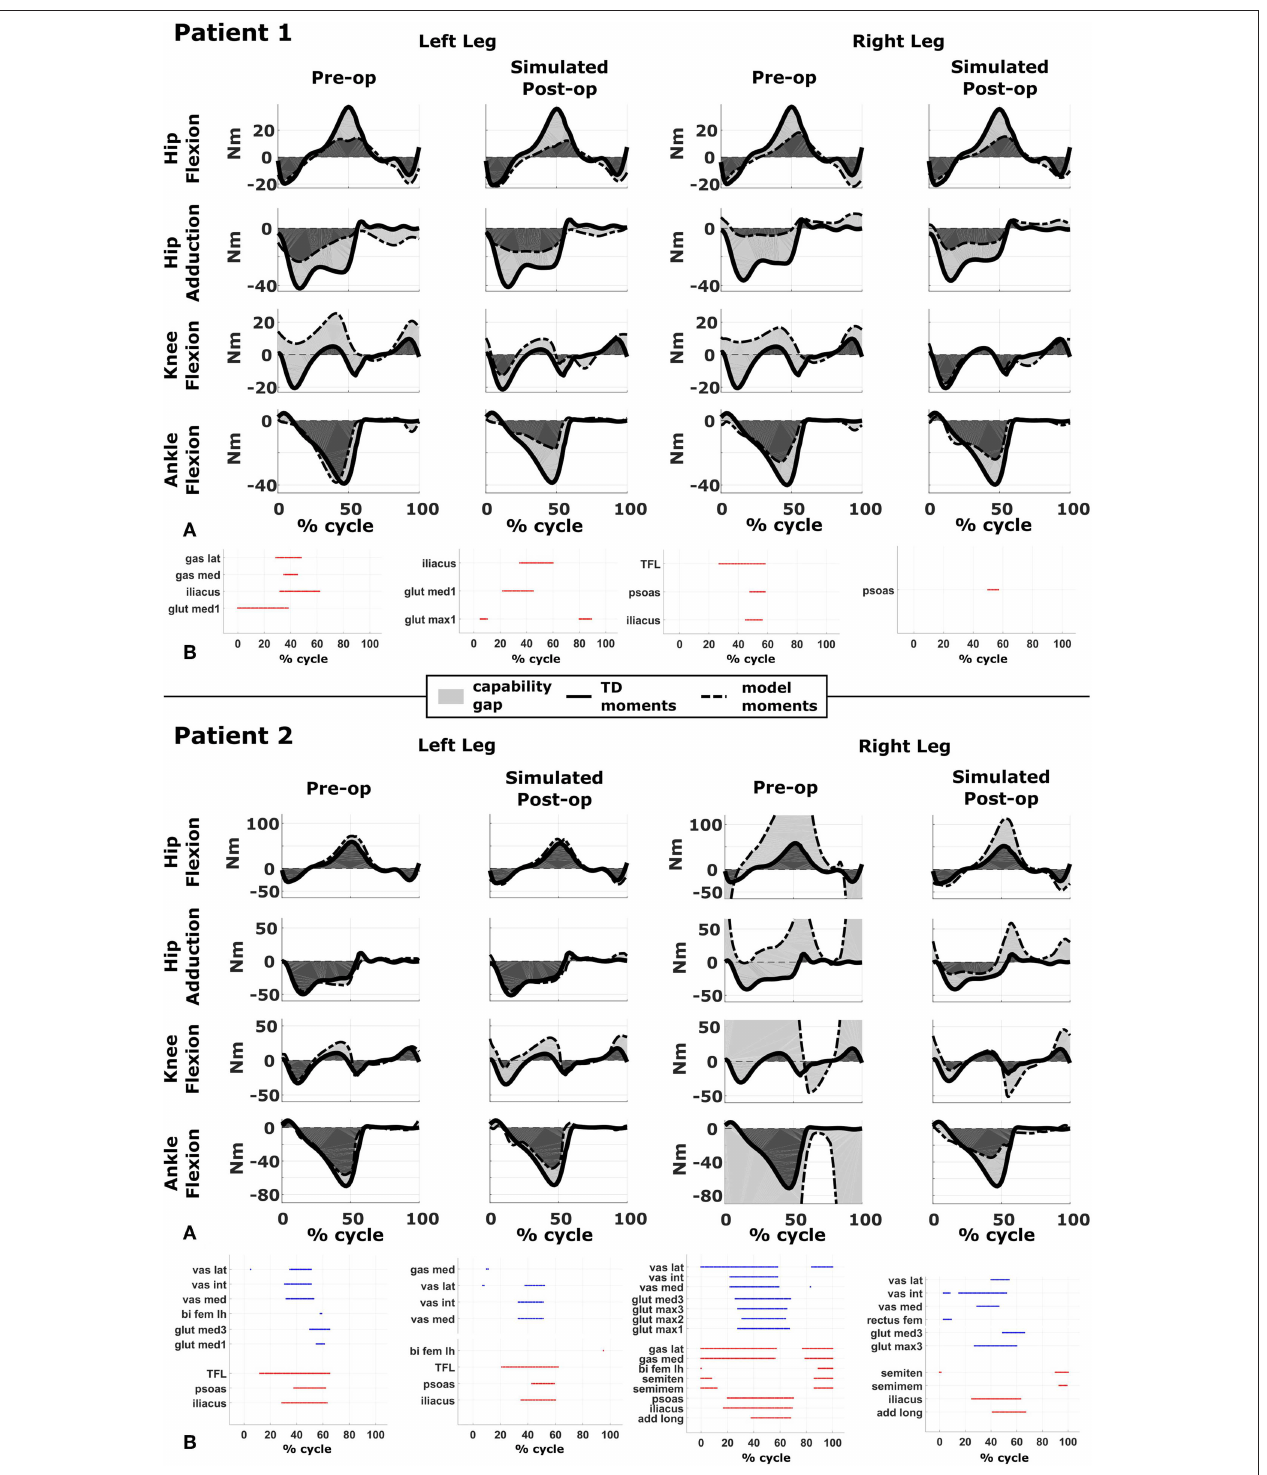
FIGURE 3 | Capability gap and report on muscle operating lengths. (A) Capability gap computed for the two representative patients, before and after the virtual surgery. The continuous black lines represent the joint moments required for the model to reach the desired kinematics [i.e., typically developed (TD) gait cycle]. Dotted black lines represent the moment exerted by the model. The light gray patches represent the capability gap. (B) Information about the operating conditions of the muscles. Blue dots represent the time instants in which muscles are active at short lengths (activation > 0.25 and normalized fiber length smaller than 0.6), red dots the intervals in which muscles are stretched, and exert an excessive passive force ( > 0.5 times the maximum isometric force).